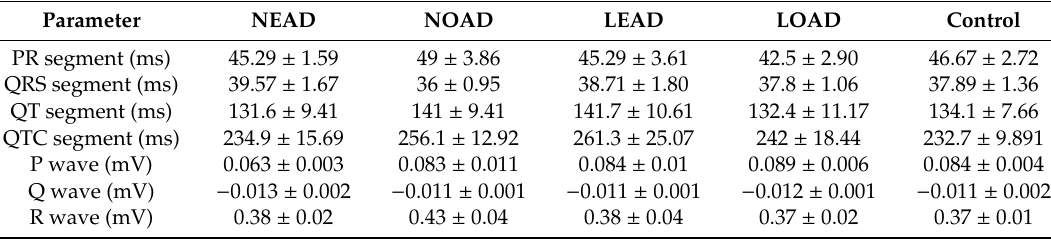
Table 2. Electrocardiographic parameters in the various groups over 60 days of treatment. Parameter NEAD LEAD LOAD Control